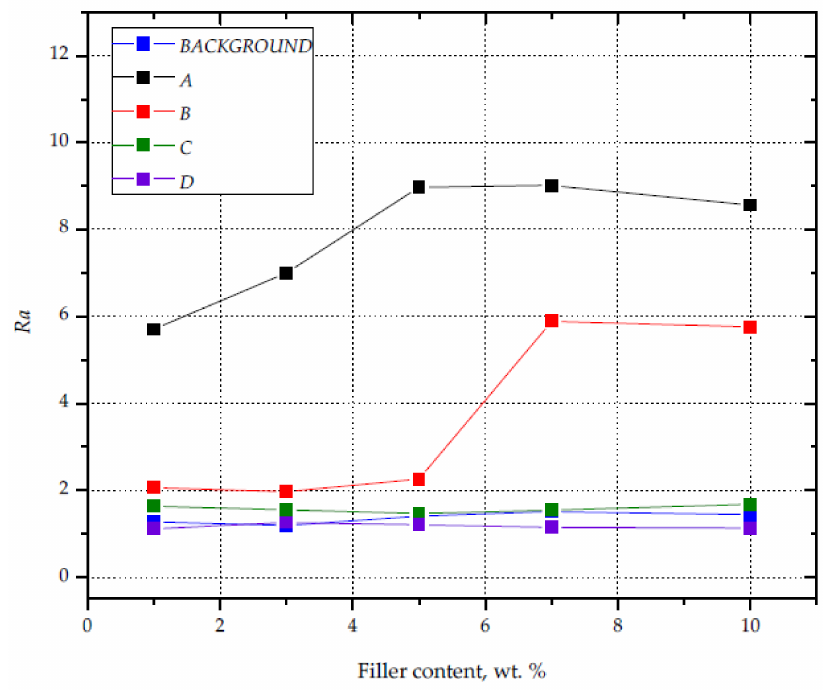
Figure 16. Surface roughness of samples with varying silica contents and different laser beam